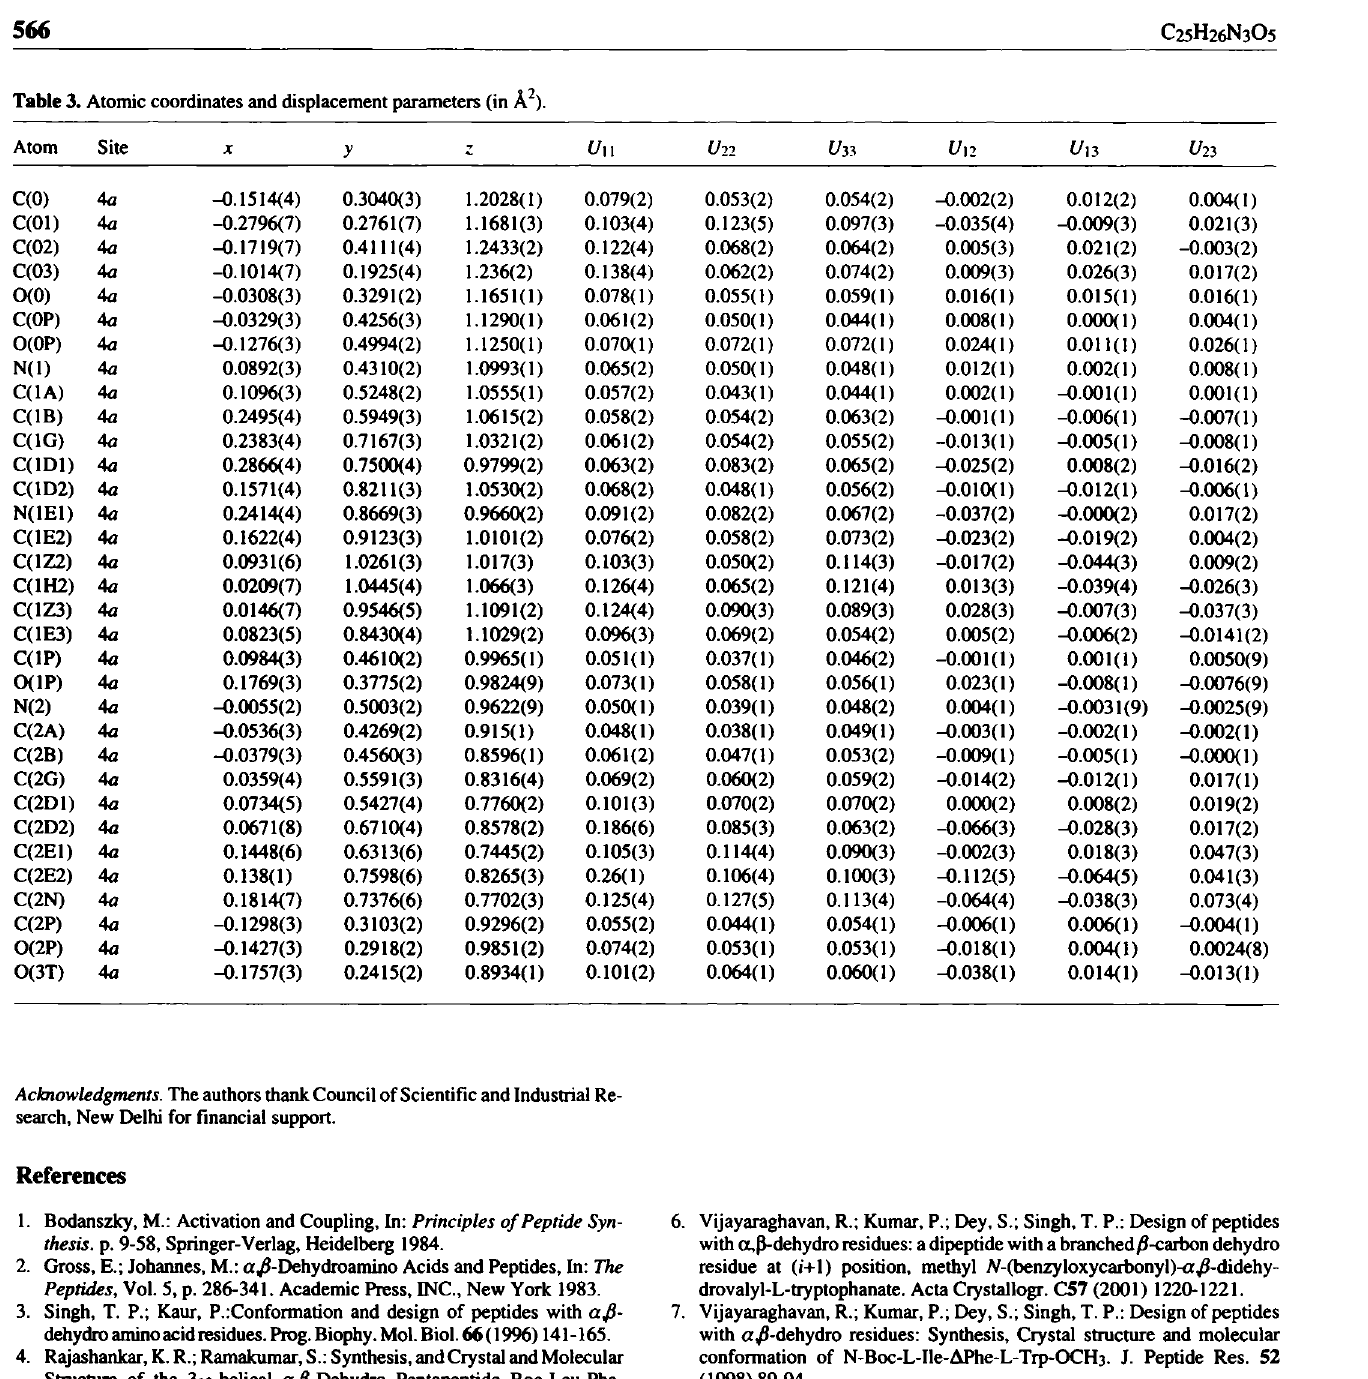
Table 3. Atomic coordinates and displacement parameters (in Â 2